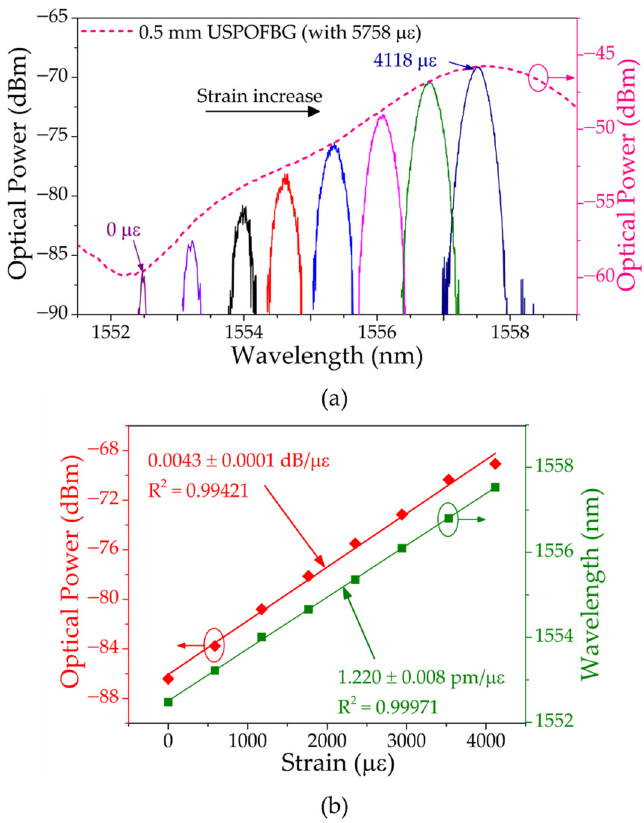
Figure 12. ( a ) Reflection spectra of the resulting signal at different levels of strain on the uniform POFBG fiber and of the USPOFBG with 5758 µε . ( b ) Corresponding wavelength and optical power shift with increasing strain.